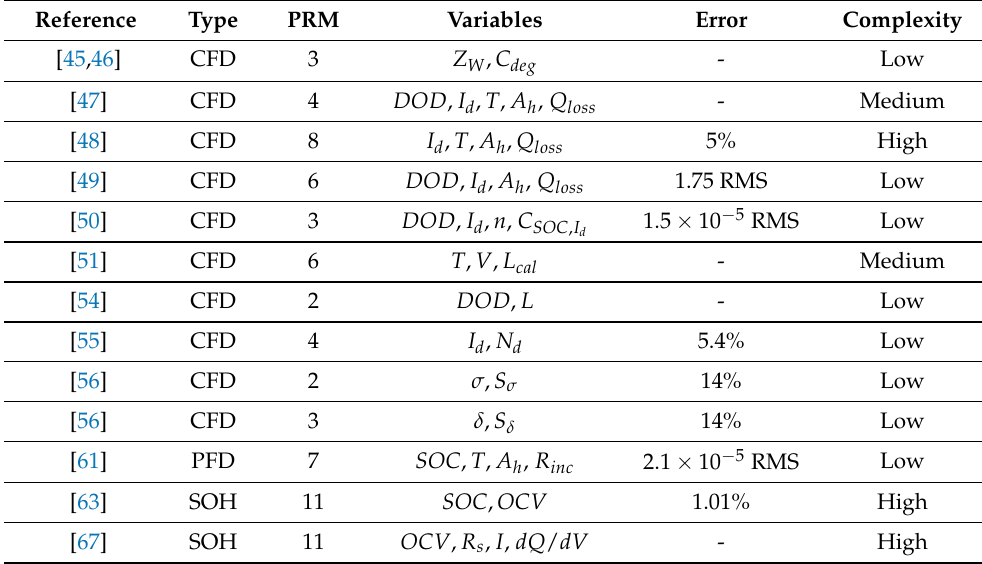
Table 4. Degradation models with electrical-related input for Li-ion batteries. CFD: capacity fade; PFD: power fade; SOH: state of